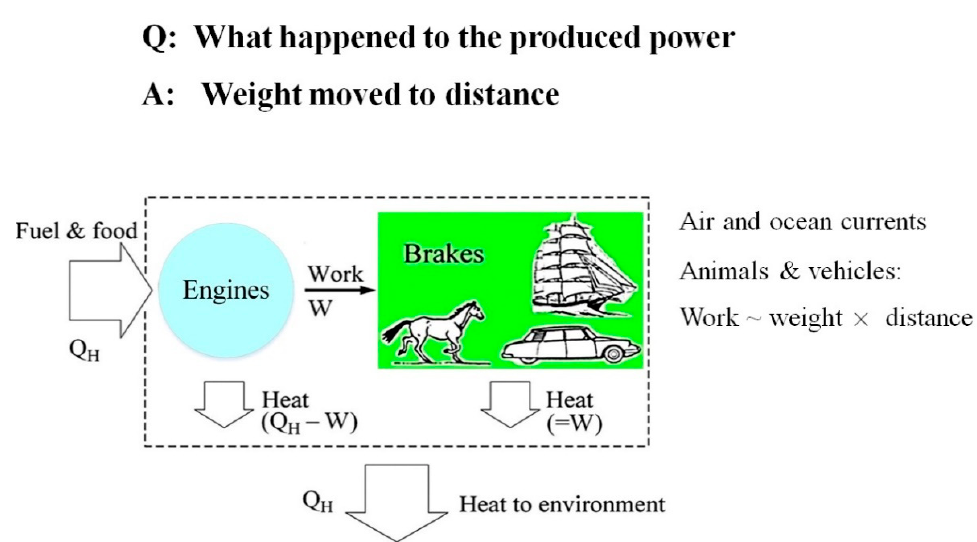
Figure 8. The complete thermodynamic system driven by useful energy (Figure 7), showing that nature is a flowing tissue of engine + brake systems, which generate power and dissipate power through fluid flow and body movement.